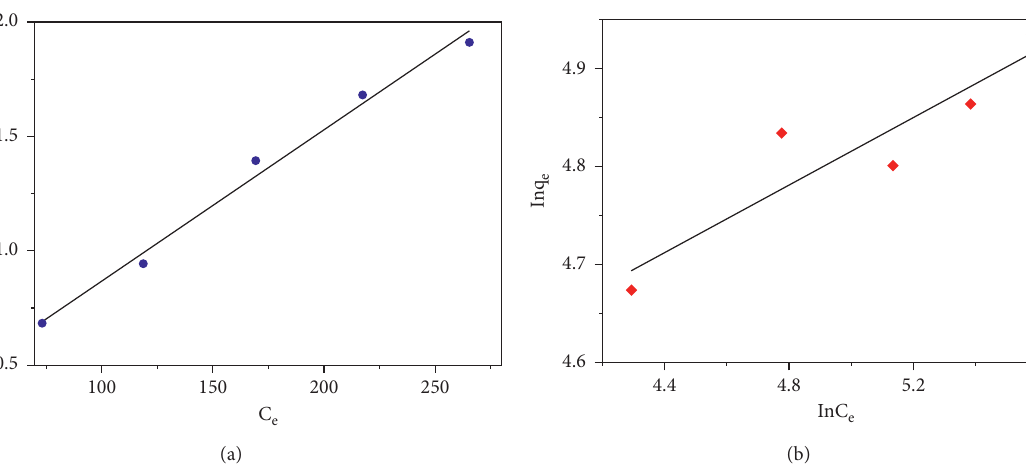
Figure 8: Adsorption isotherms of Cu(II) adsorption on PAC850-1-3: (a) Langmuir and (b) Freundlich (PACs dose: 0.0500g; temperature: 30 ° C; pH: 5; volume of of Cu(II) solution: 200ml; concentration of Cu(II): 100, 200, 300 400 and (Figure 8(b)), Temkin models, and Dubinin–Radushkevich (D-R) model.